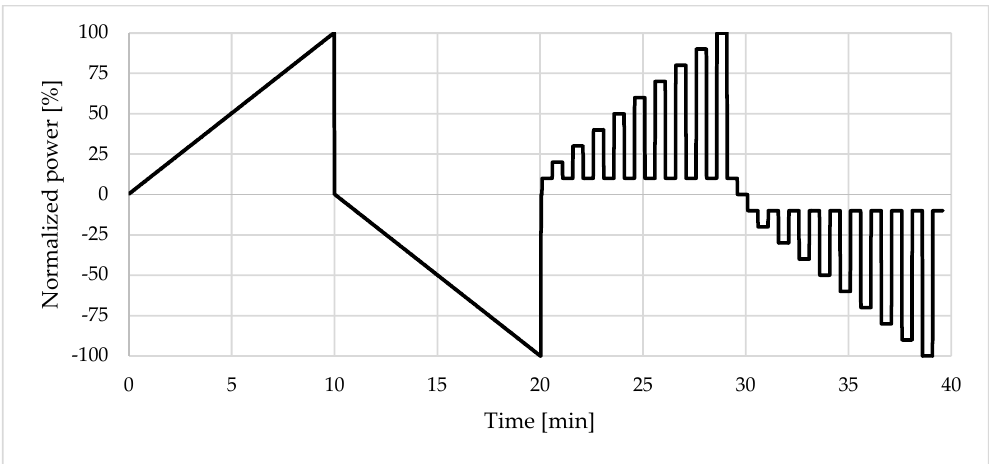
Figure 1. Proposed test pattern. Power requests are given to the electric vehicle supply equipment (EVSE), covering both charging and discharging operation modes and a range of power and power ramping values. A new power set point request is sent every 3 s during the first 20 min, and 30 s for the remaining 20 min.